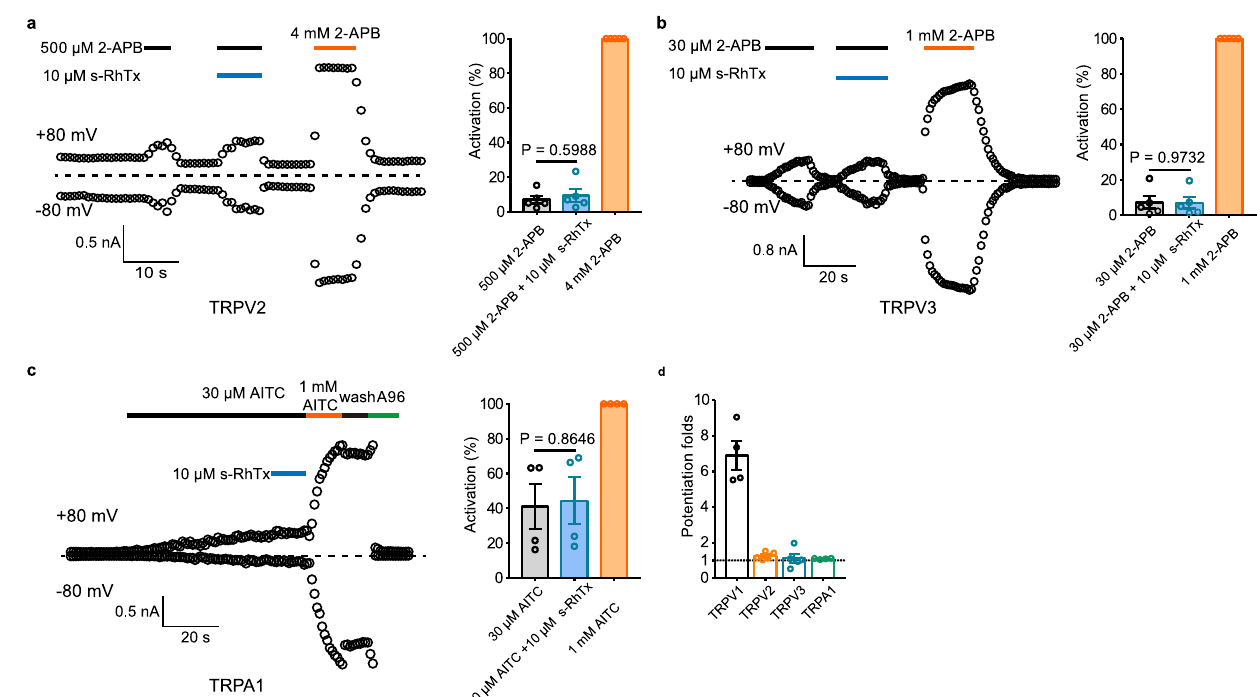
Fig. 2 | Selectivity evaluation ofs-RhTxonTRPV2, TRPV3,and TRPA1 channels expressed in HEK293T cells. a Effect of s-RhTx on TRPV2 in the presence of 500 μ M 2-APB (left) and summary of normalized current amplitude (right) (mean±S.E.M.; n =4biologicallyindependentcells);two-sided t test, P =0.5988, t = 0.55, df = 8. b Effect of s-RhTx on TRPV3 in the presence of 30 μ M 2-APB (left) and summary of activation (right) (mean±S.E.M.; n =4 biologically independent cells);